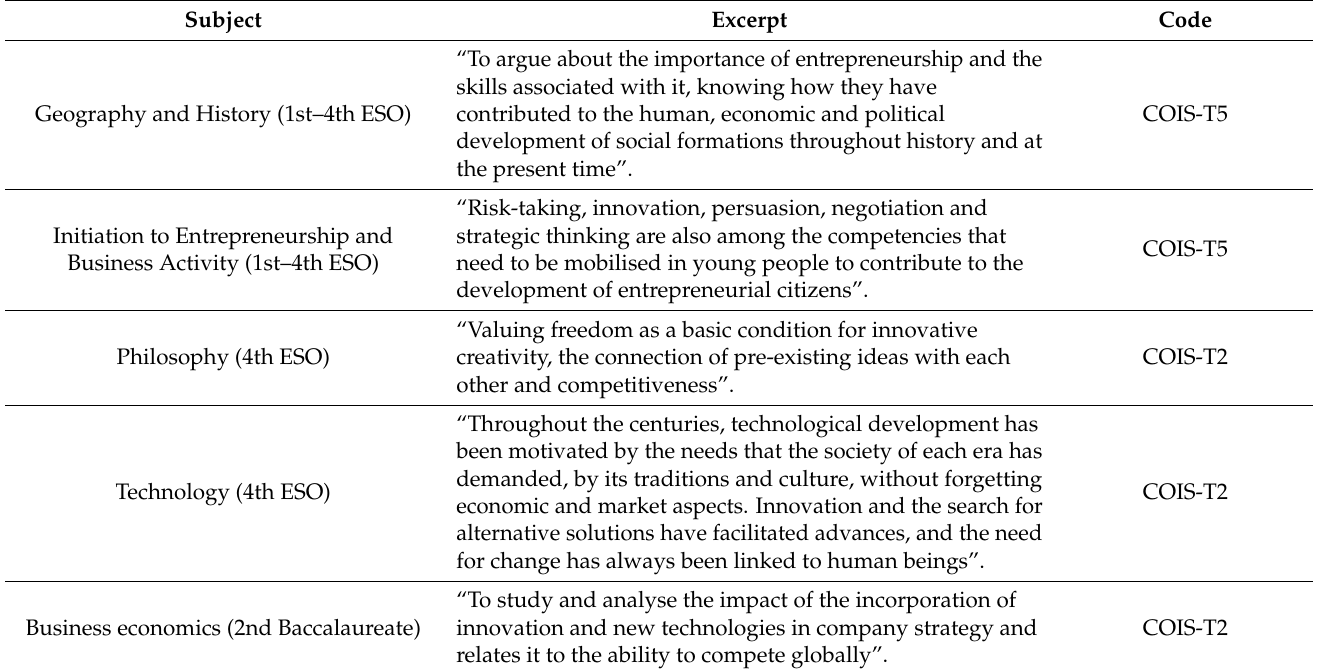
Table 6. Selection of excerpts on the topic of economic content in secondary school subjects according to the Real Decreto 1105/2014, de 26 de diciembre and the Orden de 14 de julio de